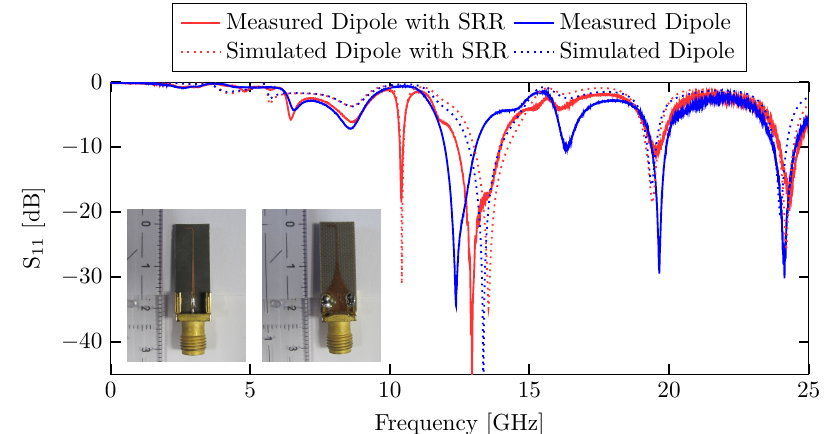
Figure 4. Simulated and measured S 11 -amplitudes of the dipole antenna with and without split-ring resonator (SRR). The reflection minima between 12GHz and 21GHz originate from the feed line and = 10.41GHz, that only occurs for the hybrid the SMA connector. The reflection minimum at f SRR antenna, corresponds to the resonance frequency of the SRR in the hybrid composite. The insets show the fabricated antenna from the front (left) and back side